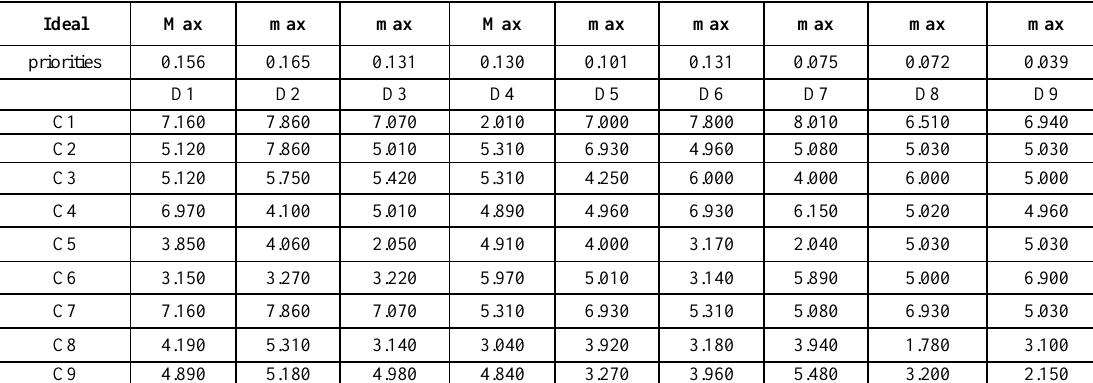
Table 4. Decision matrix for TOPSIS